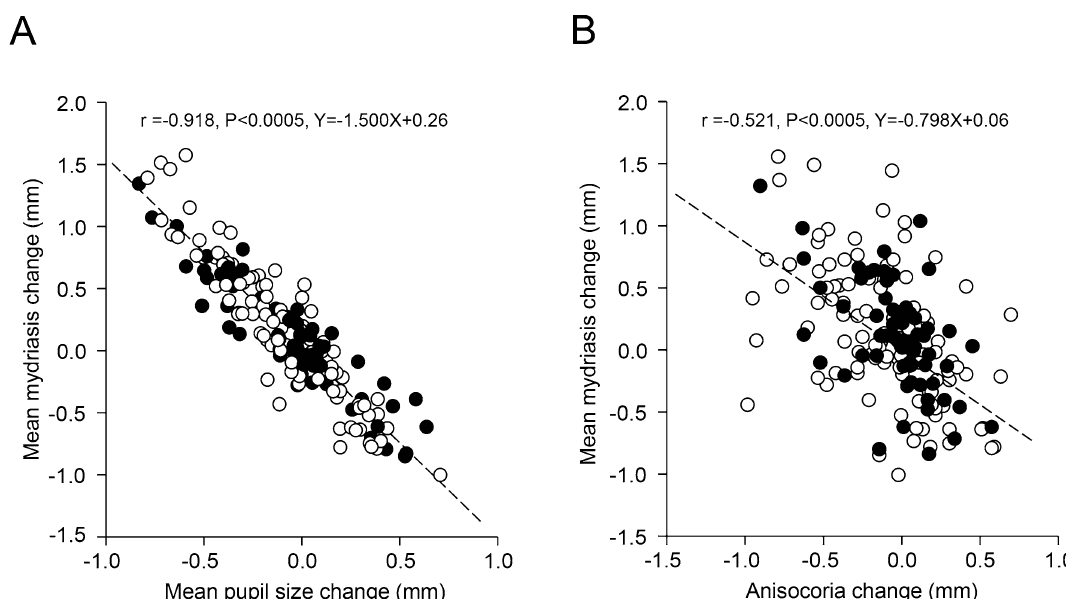
Figure 4. Relation between changes in task-related mydriasis, pupil size and anisocoria induced by modifying arches position and occlusal condition. Relation between changes in average task-related mydriasis elicited by modifying arches position and occlusal condition have been plotted as a function of the corresponding changes in average pupil size at rest (A) and anisocoria (B) . The dotted lines represent regression lines of all the plotted points, whose equations are displayed on the graphs. Dots and circles refer to TMJ disorders/edentulous and normal subjects,